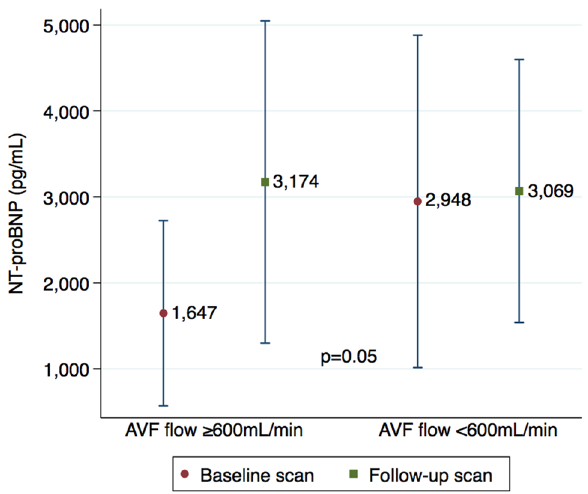
Figure 4. Effect of arteriovenous fistula (AVF) creation on N-terminal-pro B-type natriuretic peptide (NT-proBNP) levels. Changes in the blood NT-proBNP levels (picograms per millilitre) performed at the time of cardiac magnetic resonance scans according to the brachial artery blood flows (≥ 600 mL/min vs < 600 mL/min), showing a significant increase in the higher flow group compared with the lower flow AVF group(p =